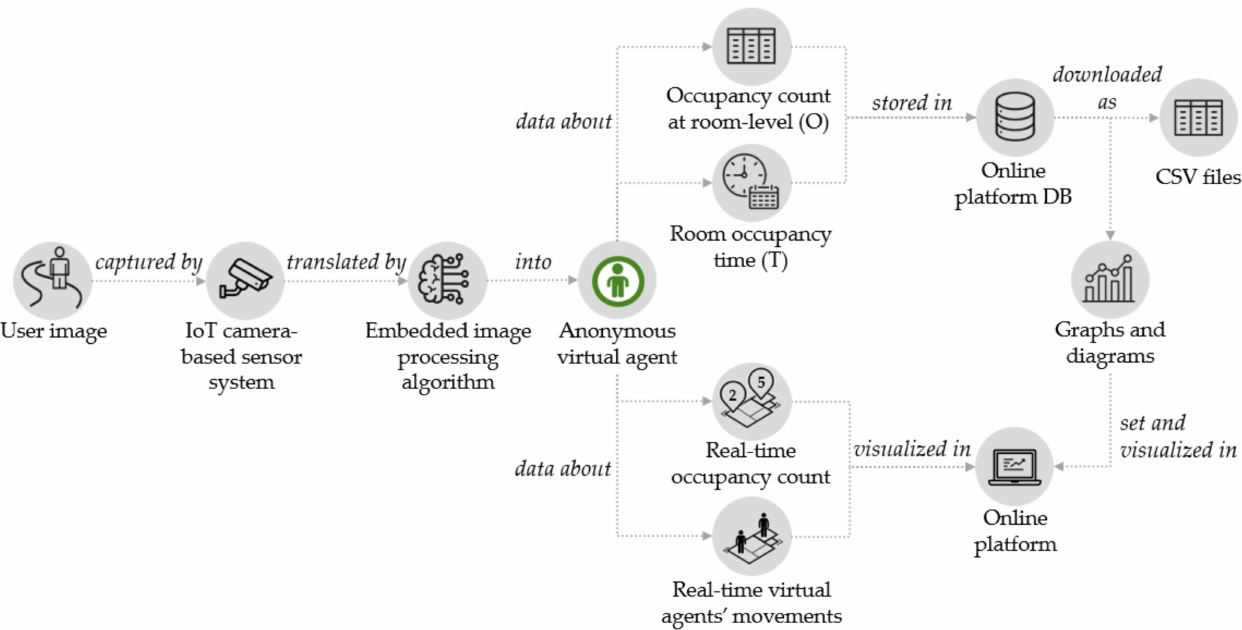
Figure 2. Data and information